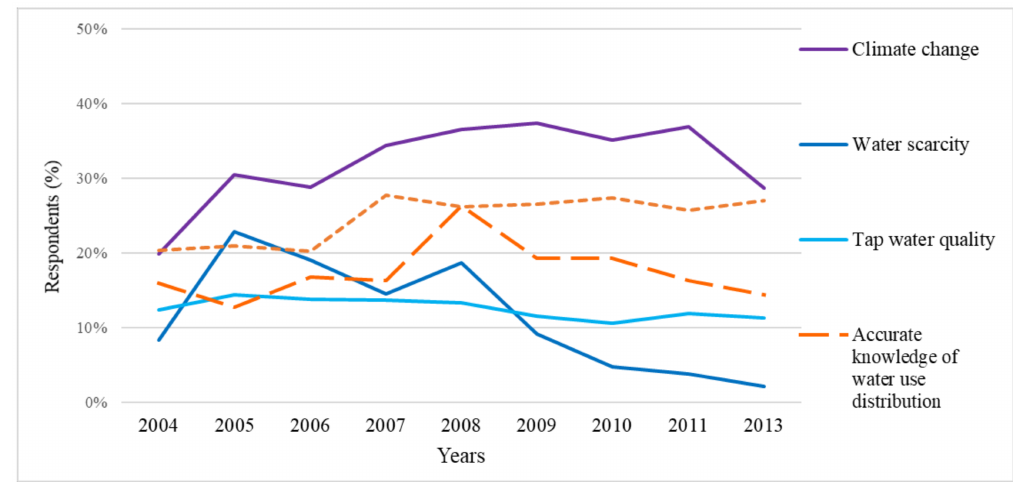
Figure 1. Contextual variables in Andalusia, 2004–2013 (%). Source: Authors’ own after Ecobar ó metro de Andaluc í a (EBA) 2001–2013